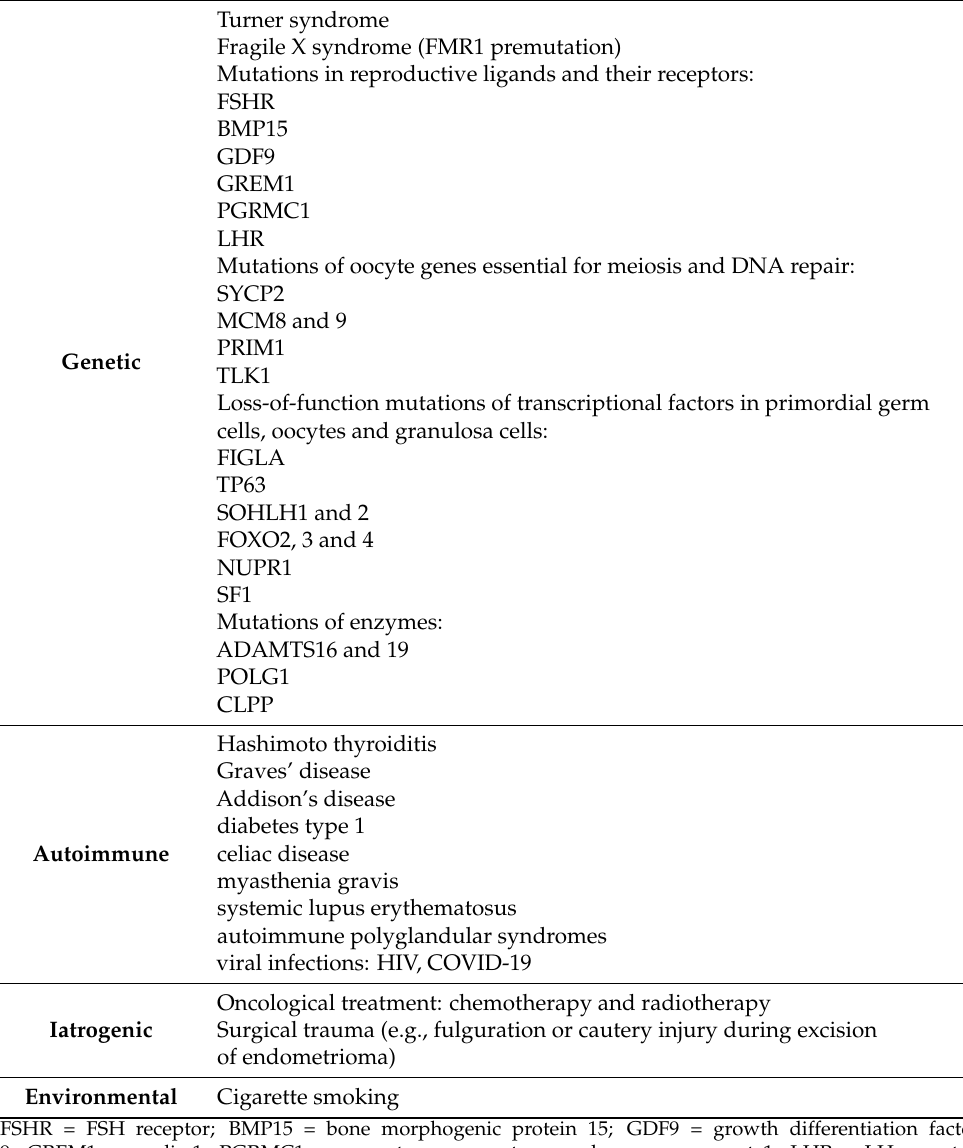
Table 1. Etiology of